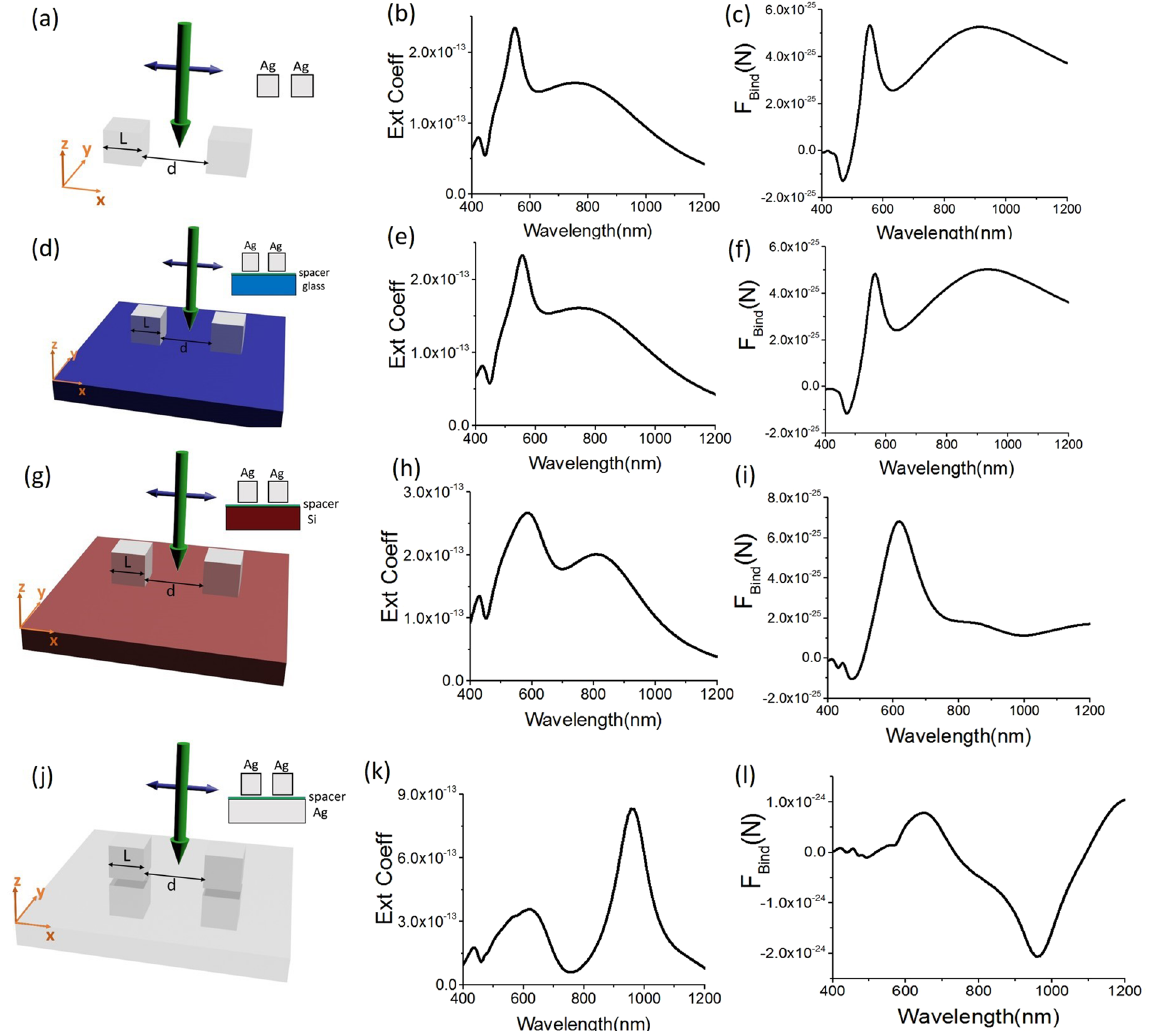
Figure 2. Two silver cubes (L = 120 nm) are placed over different substrates and their inter-particle gap, d , is 100 nm. The spacer height is always 5 nm. Cubes are placed 5 nm (h = 5 nm) away from the spacer. x -polarized plane wave is propagating towards –z -direction. ( a–c ) No substrate is placed; the extinction coefficient and binding force for that configuration. ( d–f ) Glass substrate (refractive index 1.5) is placed; the extinction coefficient and binding force for that configuration. ( g–i ) Silicon substrate is placed; the extinction coefficient and binding force for that configuration. ( j–l ) Silver substrate is placed; the extinction coefficient and binding force for that